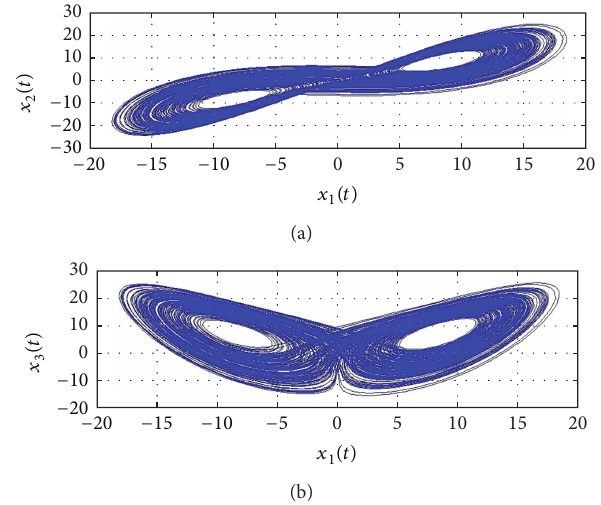
Figure 1: Projections of phase portrait of chaotic classical Lorentz system with 𝑎 = 10 , 𝑏 = 8/3 , and 𝑐 = 28